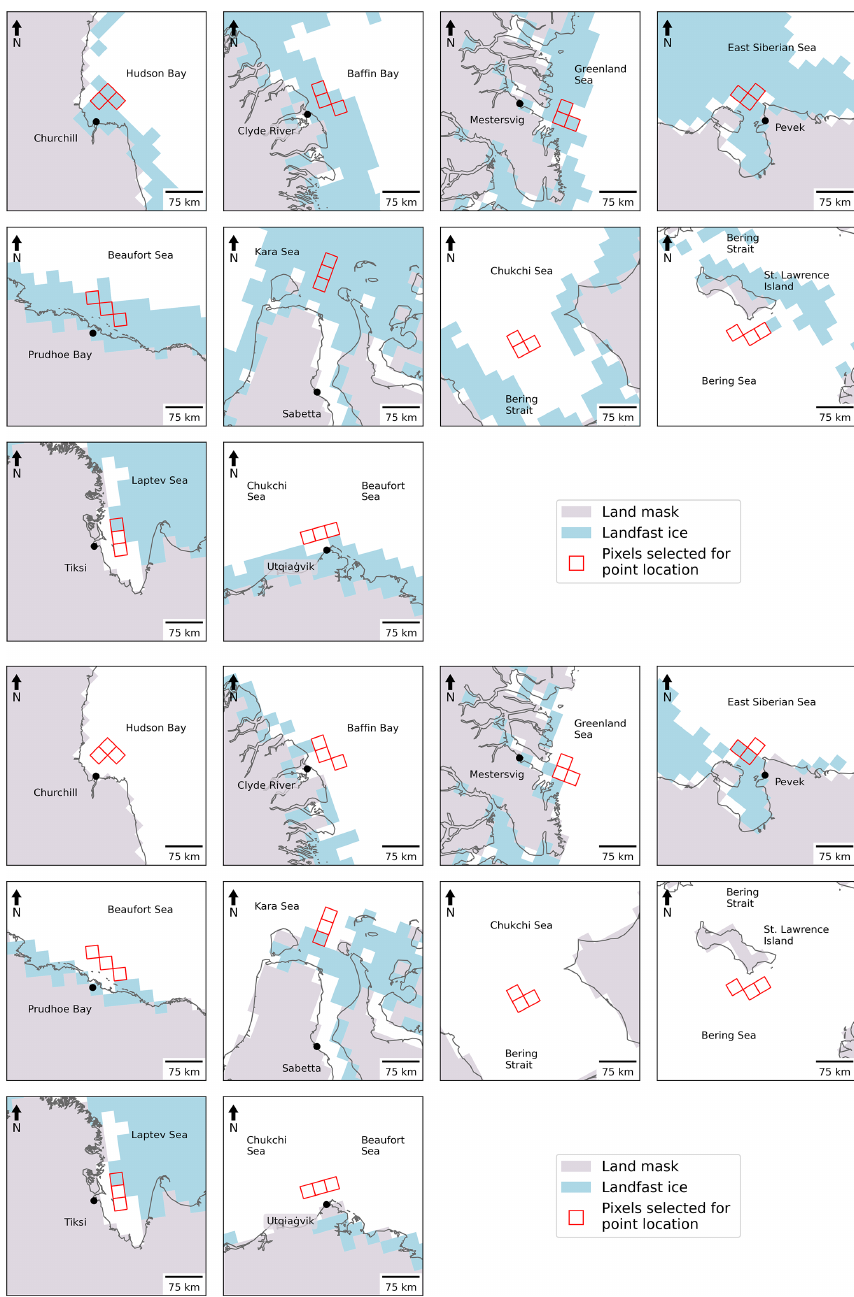
Figure 2. Grid cells (red squares) for which passive-microwave-derived ice concentrations were used in computing the breakup and freeze-up metrics for the coastal locations. Black dots represent the actual locations of the coastal communities. Blue shading denotes maximum (upper panels) and median (lower panels) coverage of landfast ice in June over the 1972–2007 period based on charts of the U.S. National Ice Center – https://nsidc.org/data/G02172 (last access: 28 June